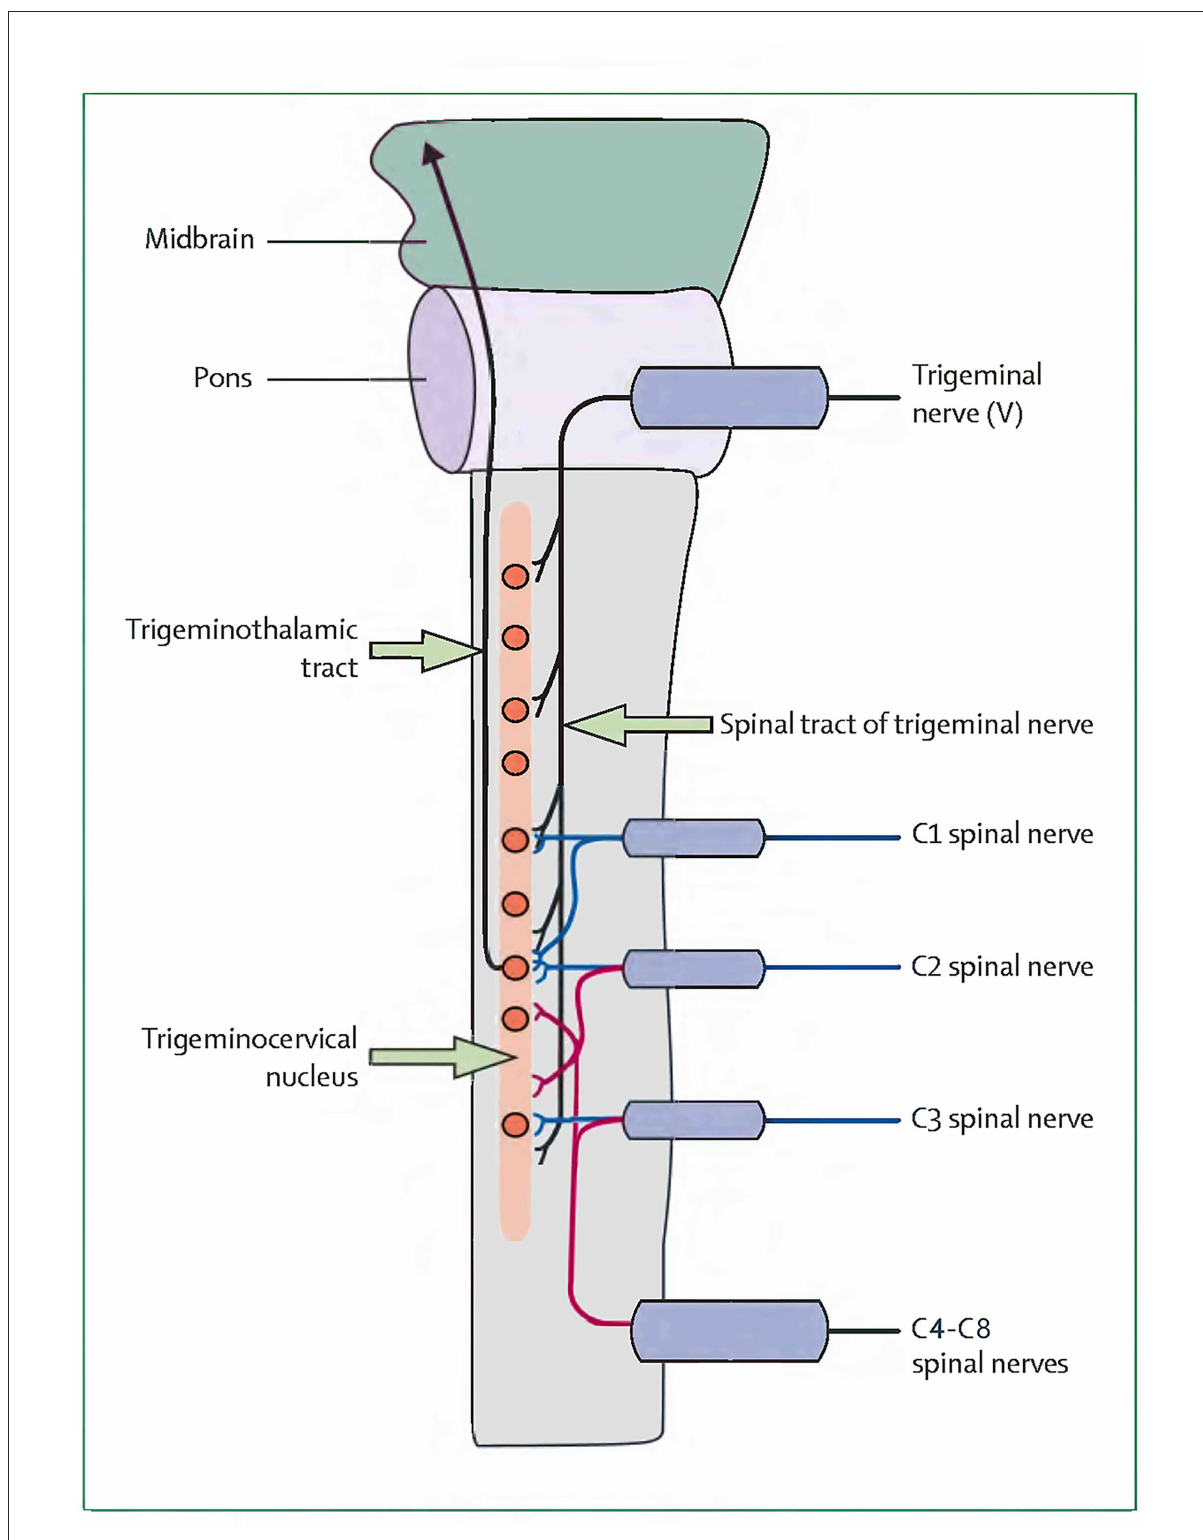
FIGURE1 A sketch of the headache referral from C1 to C8 spinal